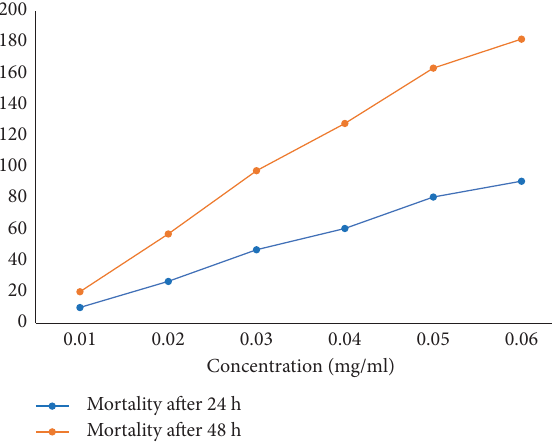
Figure 2: Mortality percentage in D. stramonium purifed protein at diferent concentrations of protein solution.